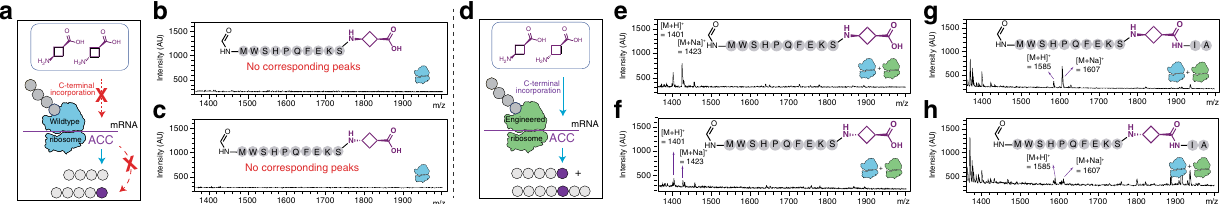
Fig. 5 Ribosomal synthesis of peptides with aminocyclobutane-carboxylic acid (ACB). a Peptides were synthesized in the PURExpress TM system using Fx-mediated tRNA Pro1E2 (GGU), puri fi ed via the Streptavidin tag, and characterized by MALDI mass spectrometry. b and c cis- ACB and trans -ACB are not incorporated into the C-terminus of a peptide by the wild-type ribosome. d Engineered ribosomes facilitate C-terminal and mid-chain incorporation of cis/trans -ACB into peptides. e and f cis- ACB and trans -ACB. Peptides containing cis/trans -ACB at the C-terminus were observed when an engineered ribosome, developed by Maini et al. 24,58 , was added into the protein translation reaction in vitro. g and h cis and trans -ACB. Additional amino acid residues (Ile and Ala) were elongated after the incorporation of cis/trans -ACB, demonstrating that the engineered ribosome enabled site-speci fi c incorporation of ACB. Data are representative of three independent experiments. See Supplementary Fig. 2 for full